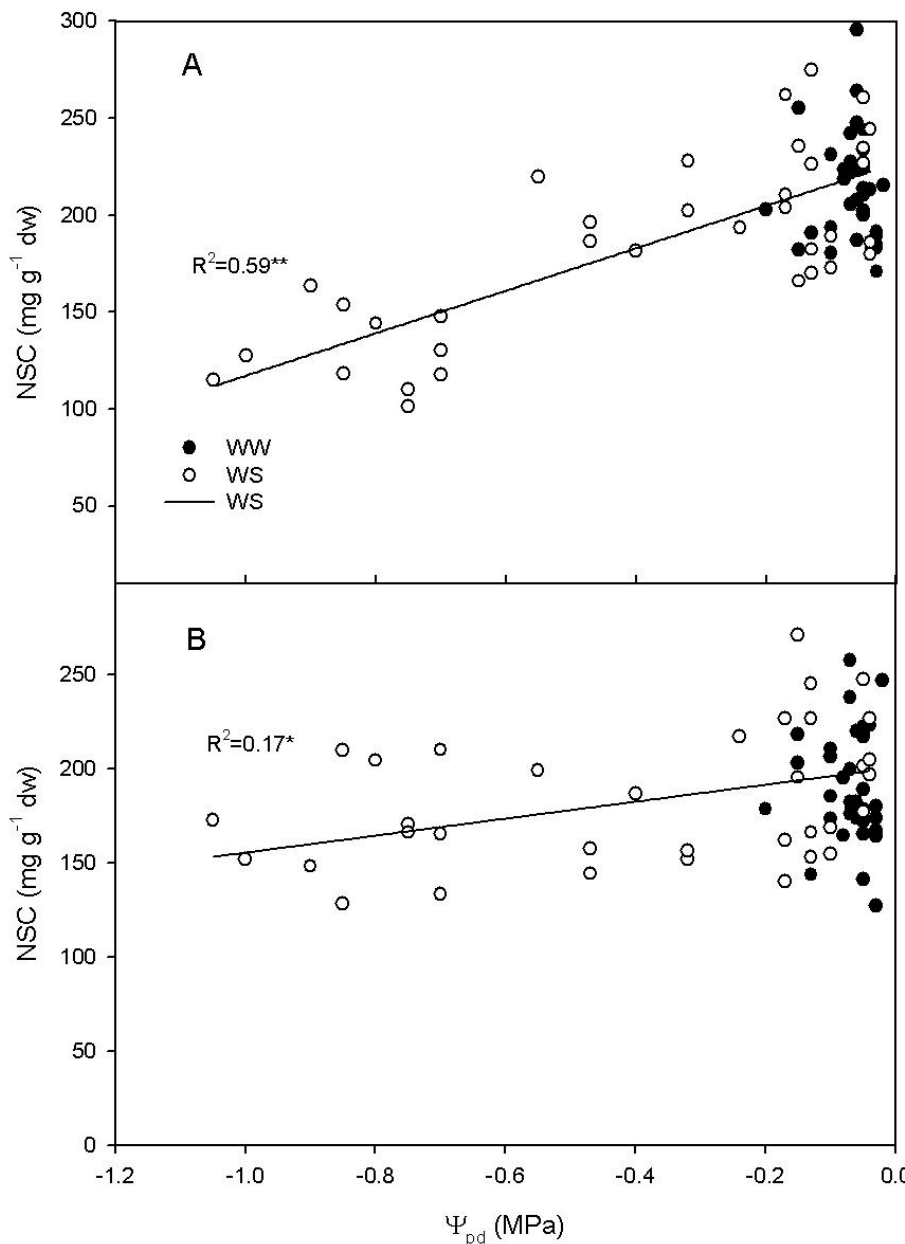
Figure 7. Relationship between non-structural carbohydrates (NSC) and pre-dawn water potential (Ψ pd ) in water stressed (WS) vines at ( A ) midday (y = 0.23 + 0.11x, R 2 = 0.59 p < 0.0001) and at ( B ) 4:00 a.m. (y = 0.20 + 0.04x, R 2 = 0.17 p = 0.011) during water stress from DOY 181 to DOY 187. * indicates p < 0.05; ** indicates p < 0.0001.